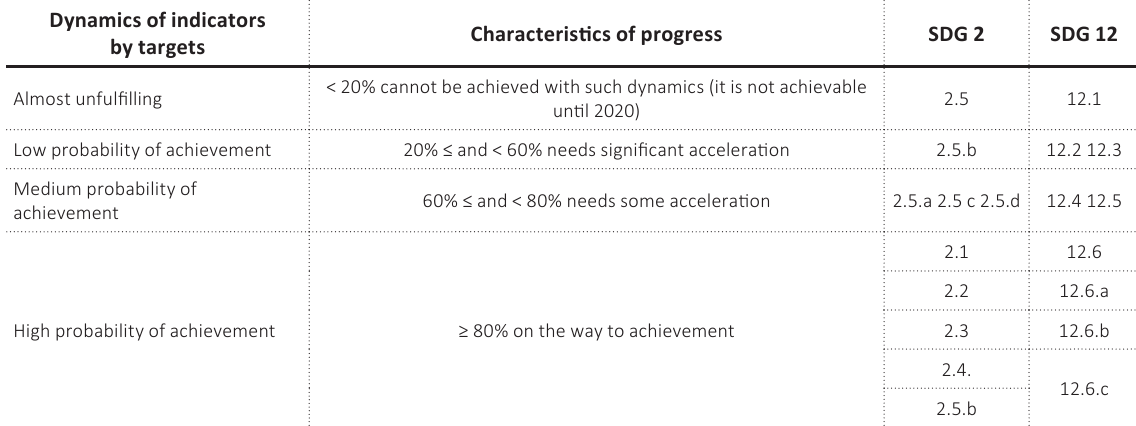
Table 3. Assessment of progress in achieving the targets of SDGs 2 and 12 in the Czech Republic based on national monitoring data